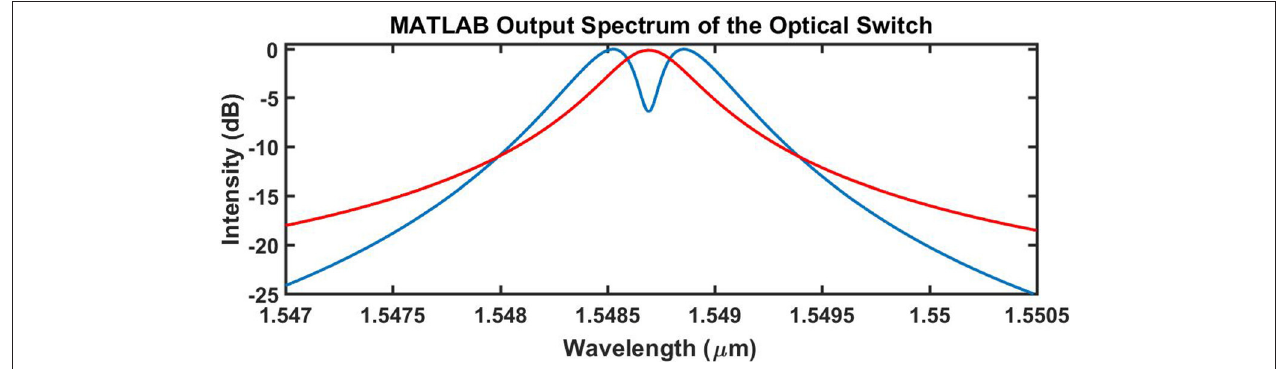
FIGURE 3 | The output spectra at the combined drop port